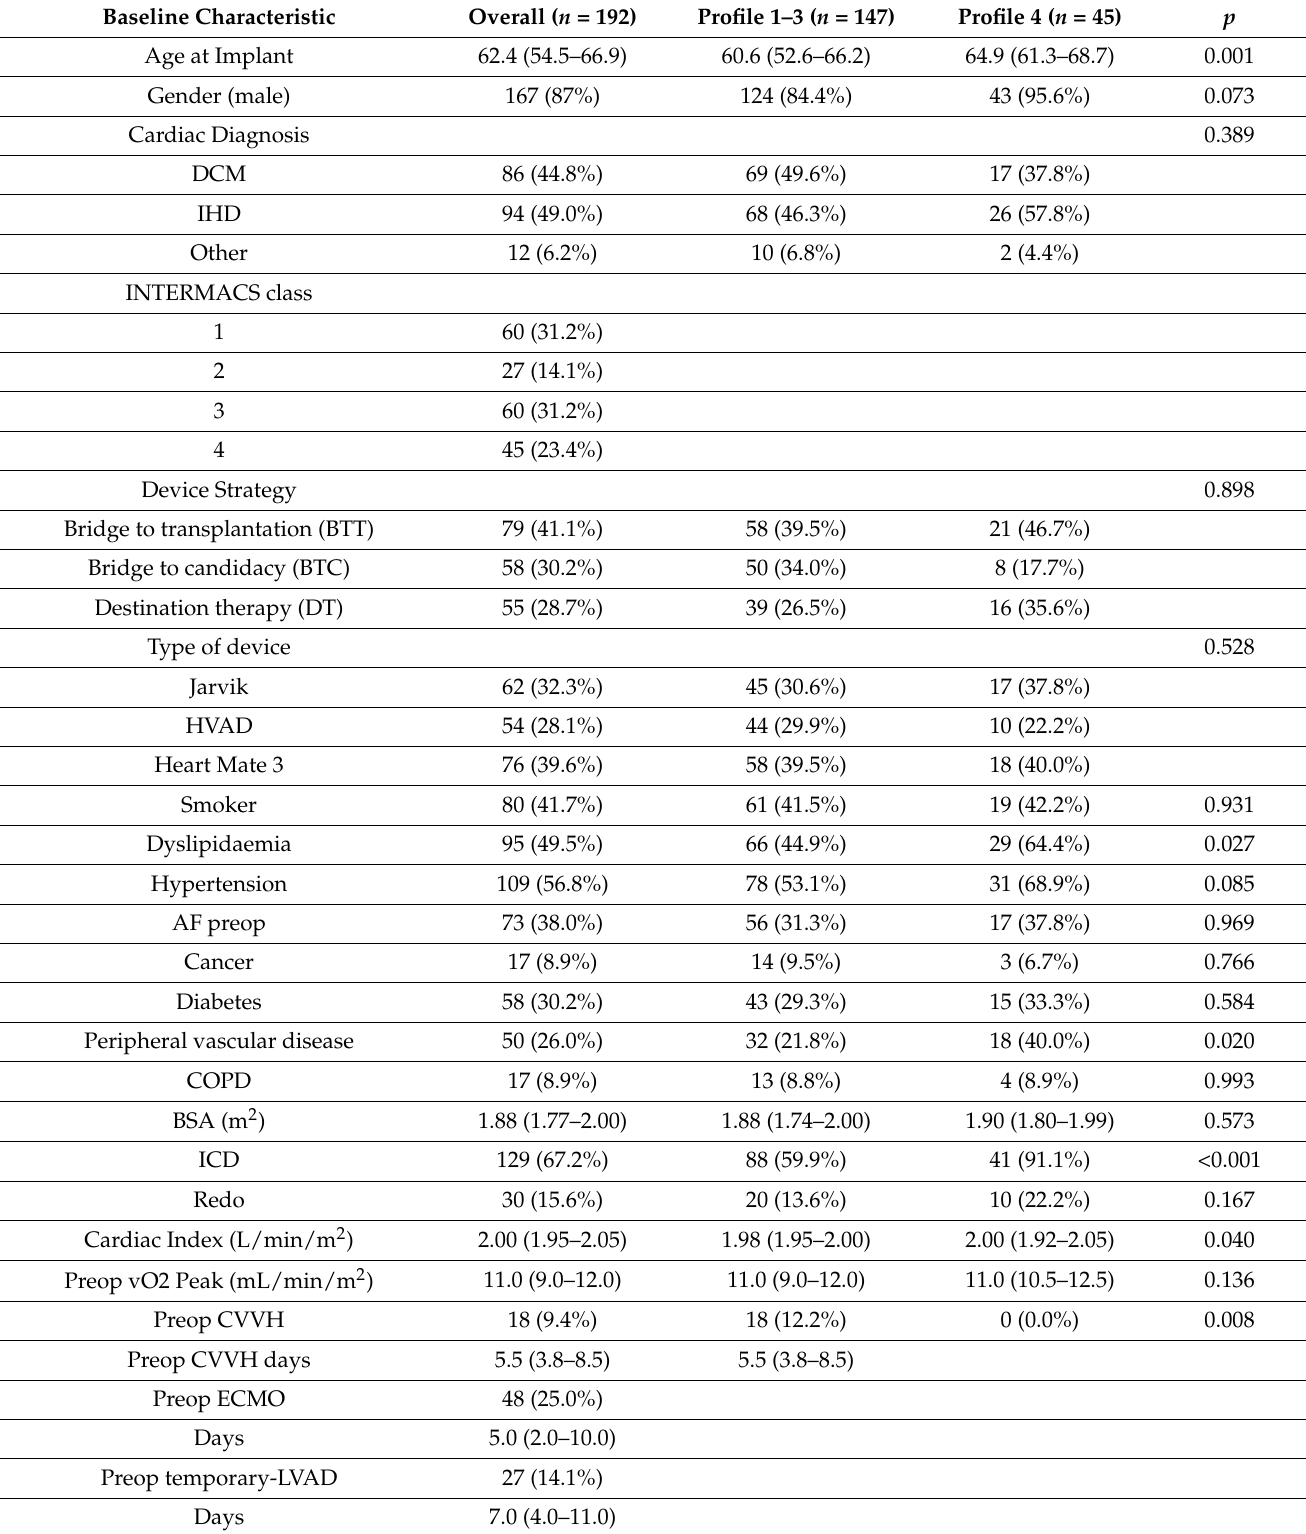
Table 1. Baseline characteristics, preoperative labs, and echocardiogram parameters of overall ( n = 192), INTERMACS Profile 1–3 ( n = 147) and Profile 4 ( n = 45)